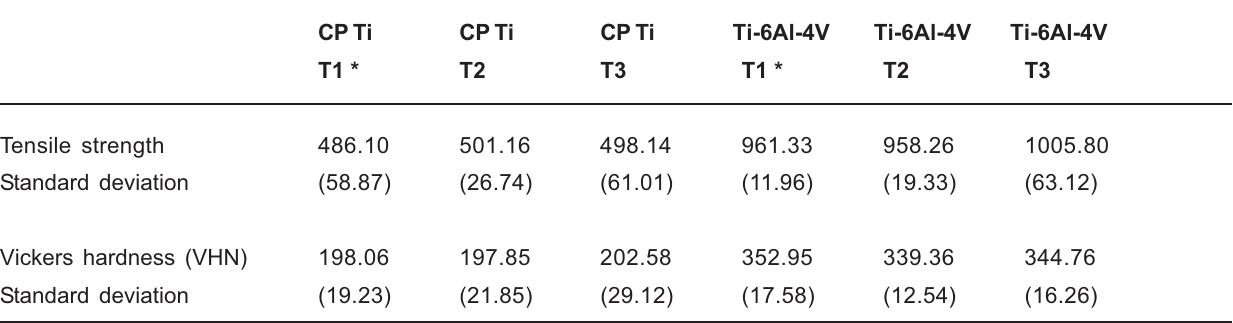
TABLE 2- Mean values of tensile strenght (MPa) and Vickers hardness and standard deviation to both materials in the three temperatures (TI, T2 and T3)